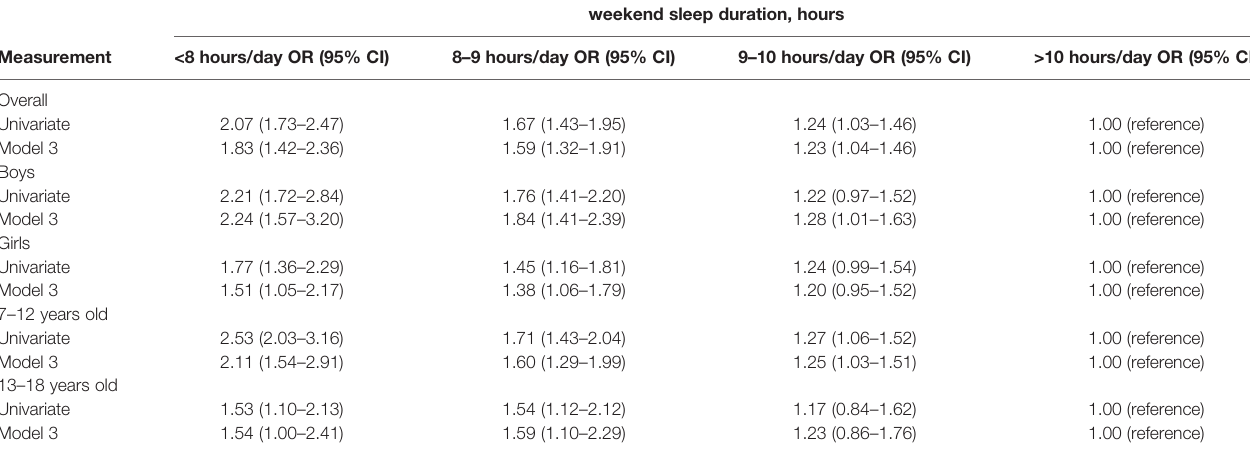
TABLE 2 | Unconditional logistic regression analysis of associations between weekend sleep duration and abdominal